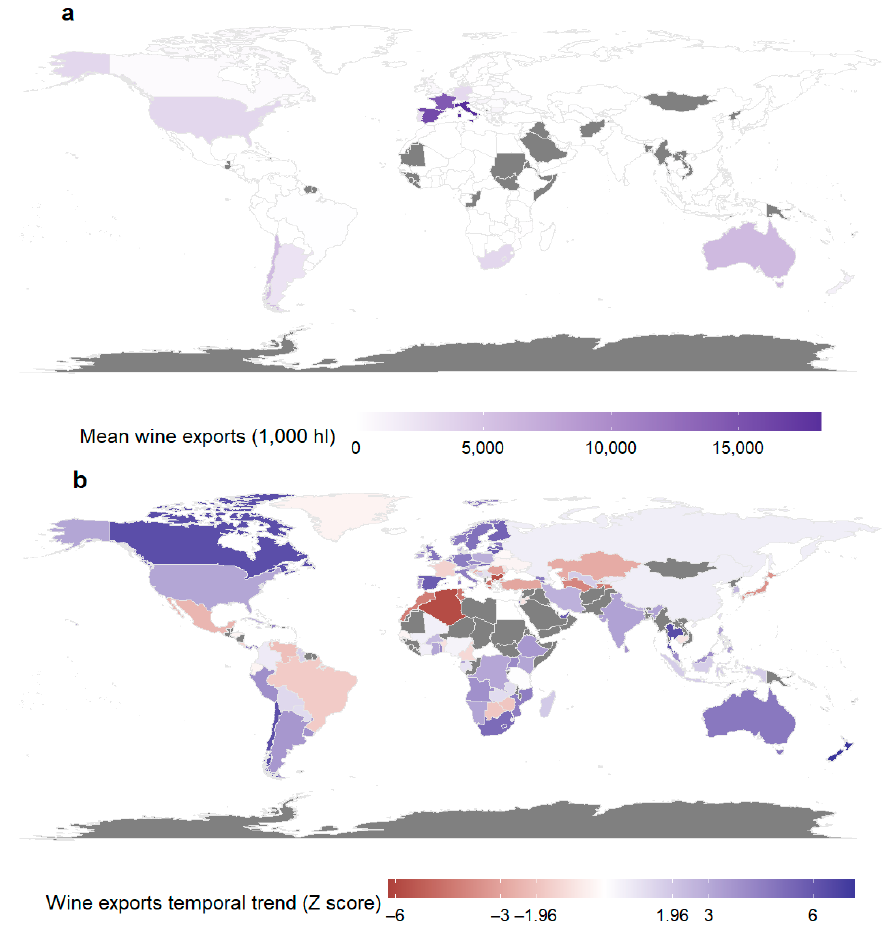
Figure 6. Wine export representation for each country, including mean long-term quantities ( a ); and Z-score for each country, signifying the extent of the temporal trend over 27 years ( b ). Countries in grey represent no data.